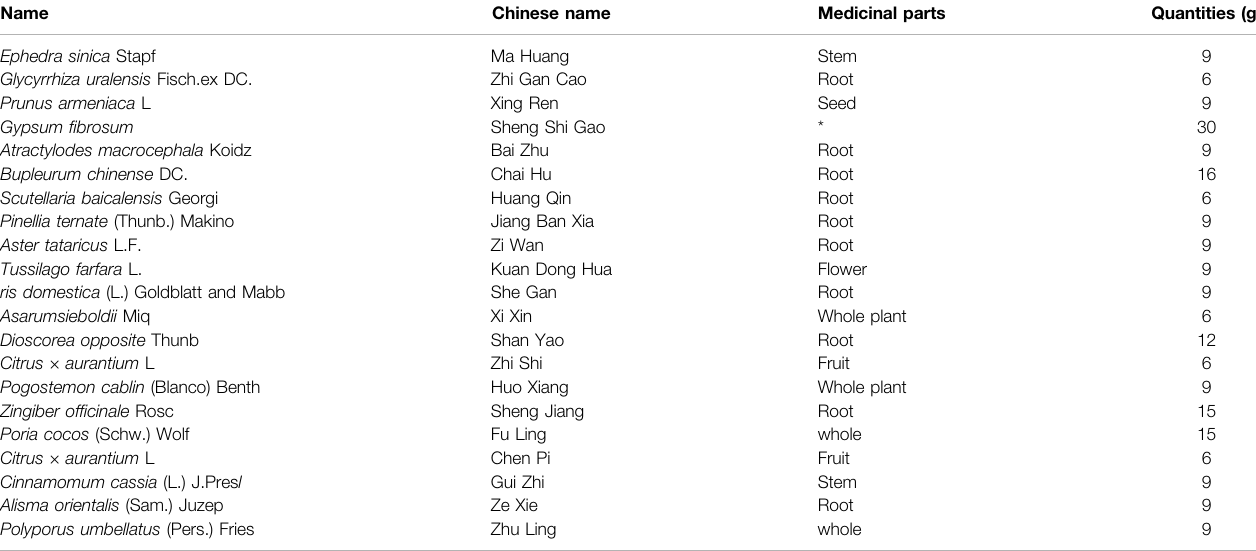
TABLE 1 | Raw materials of Qingfei Paidu decoction.